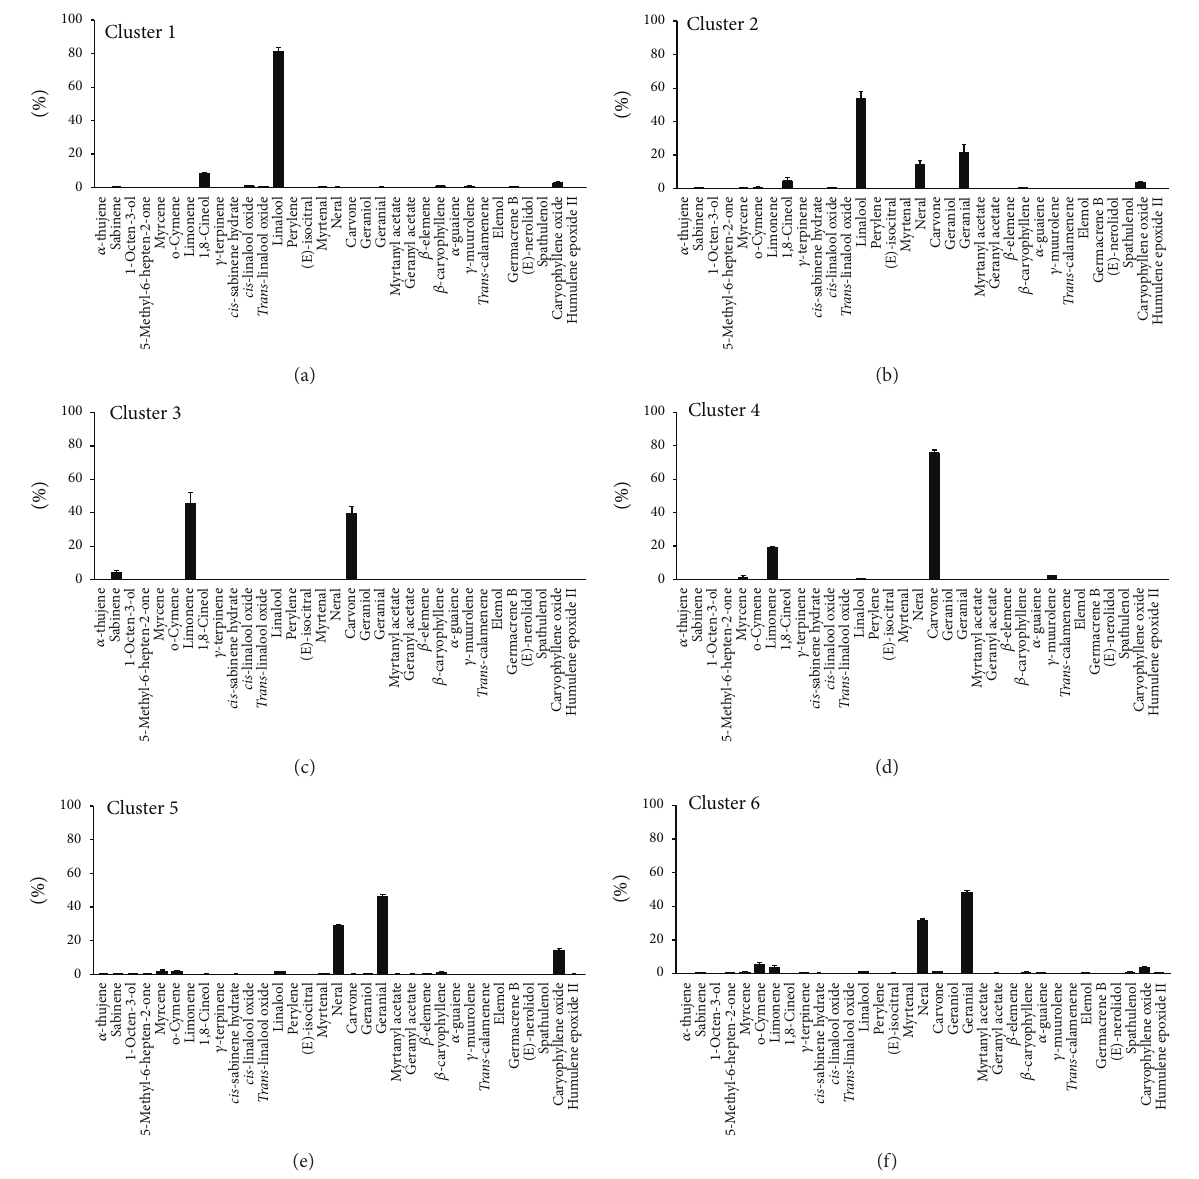
Figure 2: Means and SEM for the chemical compounds in the essential oils from clusters 1 through 6 of L. alba